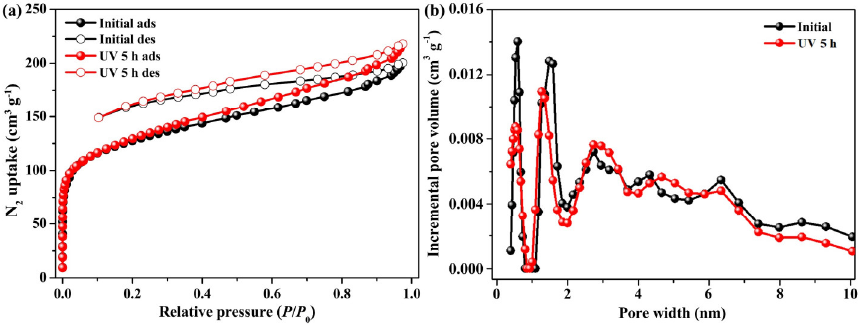
Figure 3. ( a ) N 2 adsorption and desorption isotherms and ( b ) pore size distributions of initial JJU-1 (black) and after UV irradiation for 5 h (red).